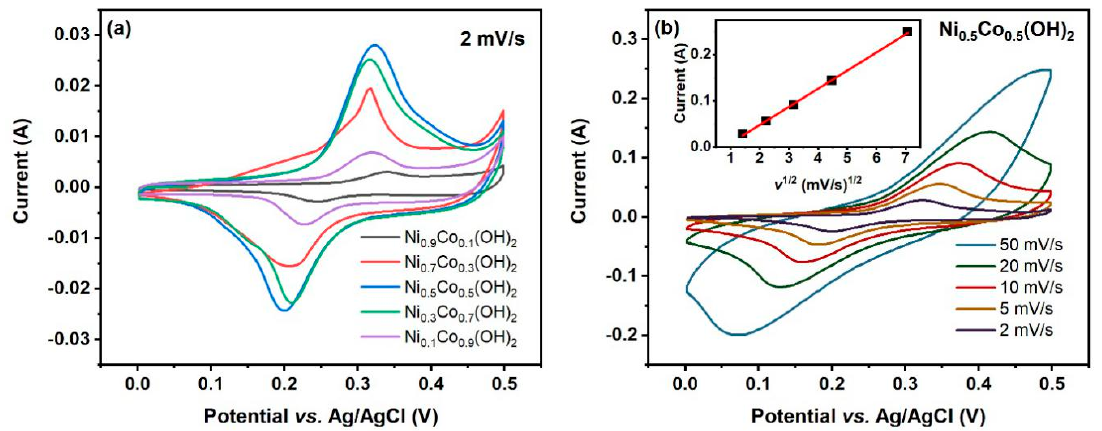
Figure 4. ( a ) Cyclic voltammetry (CV) curves of the Ni 1-x Co x (OH) 2 electrodes at scan rate of 2 mV/s. ( b ) CV curves of the Ni 0.5 Co 0.5 (OH) 2 electrode at scan rates from 2 to 50 mV/s.